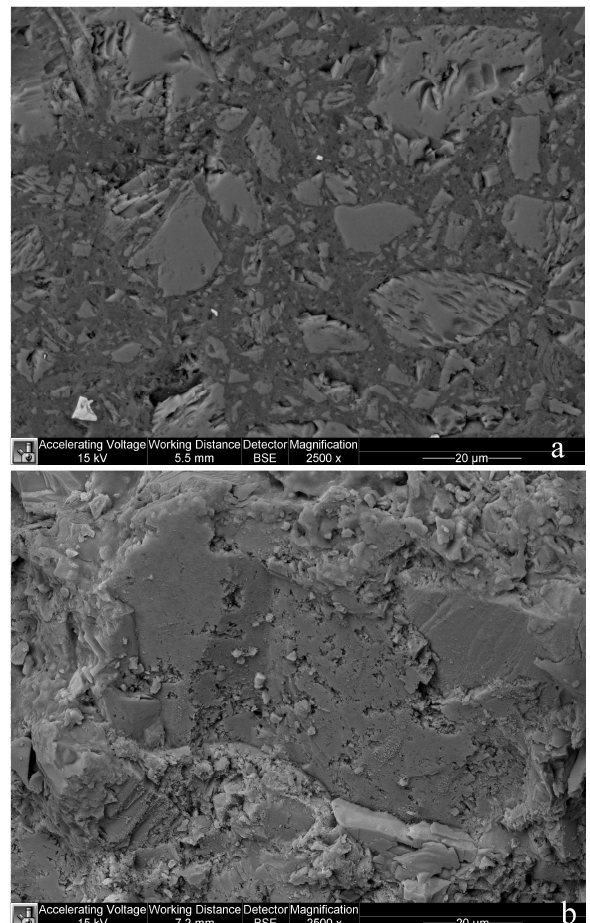
Figure 5. ( a ) Polished section SEM BSE micrograph showing a typical microstructure for reacted powder sample R0810. Note the very low porosity of the magnesite cement phase closely surrounding the olivine grains. ( b ) Fractured surface micrograph of sample R0810, showing very fine-grained magnesite precipitation probably formed along a grain surface.